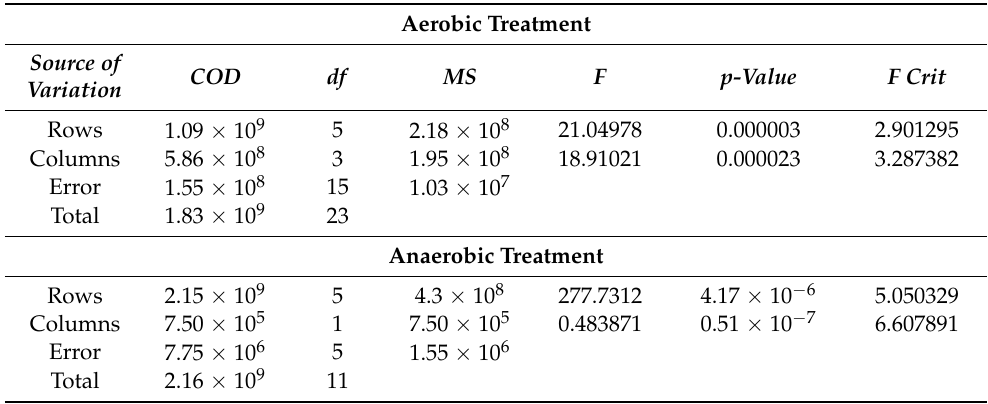
Table 2. Analysis of variance (ANOVA) test of COD solubilization of aerobic and anaerobic